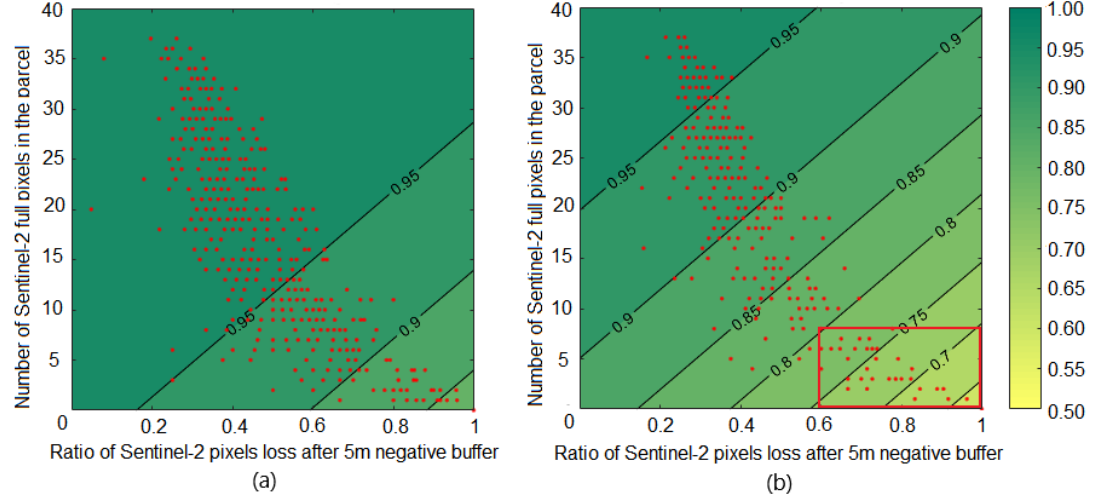
Figure 8. Model quantifying the probability of exceeding the correlation coe ffi cient value of 0.75 as a function of the number of full pixels in the parcel and the percentage of pixels that are lost after application of the 5 m bu ff er. ( a ) Parcels with the same crop surroundings and ( b ) parcels with di ff erent crop surroundings. The background colors represent the variability of the probability. The red box illustrates the limiting criteria.